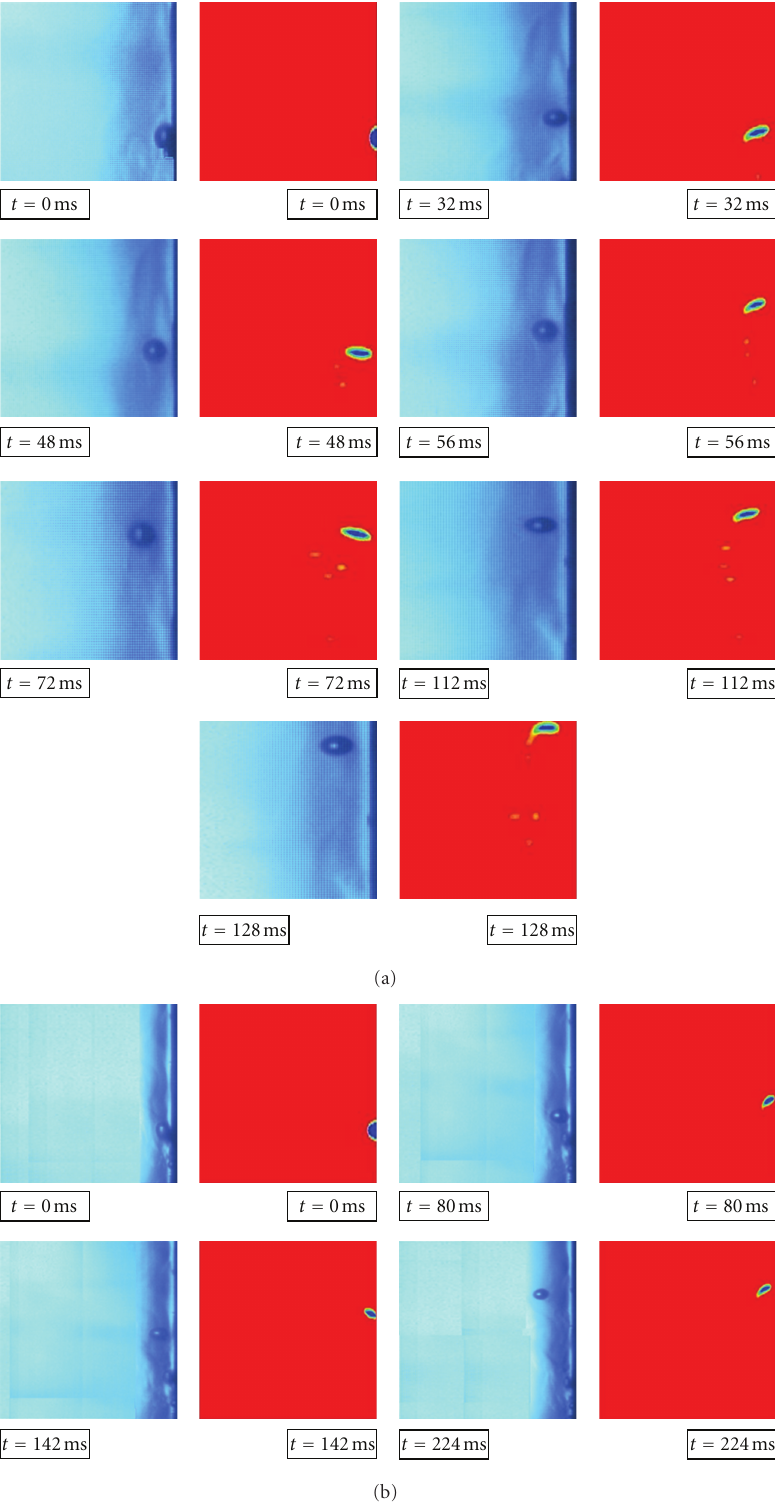
Figure 7: Comparison of bubble movement with high-speed photography and VOF simulations. (a) Ra = 8 × 10 12 (b) Ra = 1 . 8 × 10 13